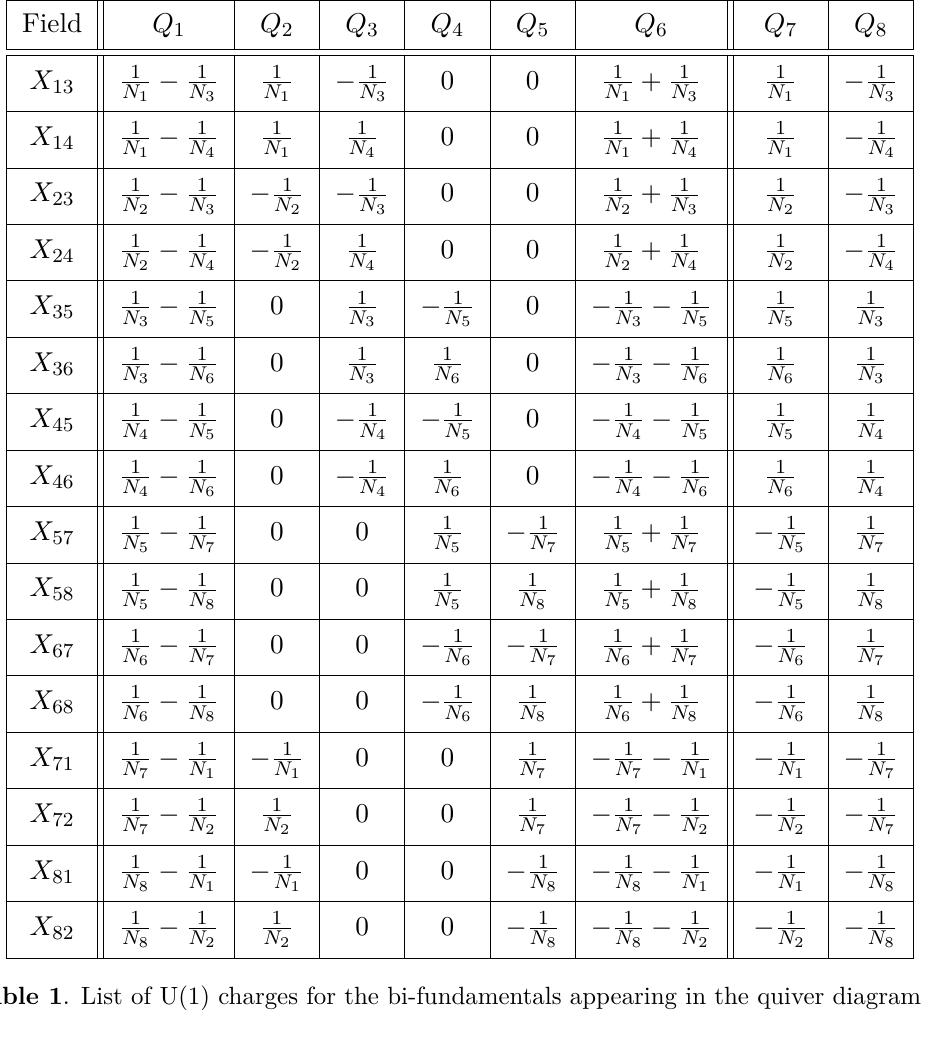
The 2 anomalous 10 U(1) ’s